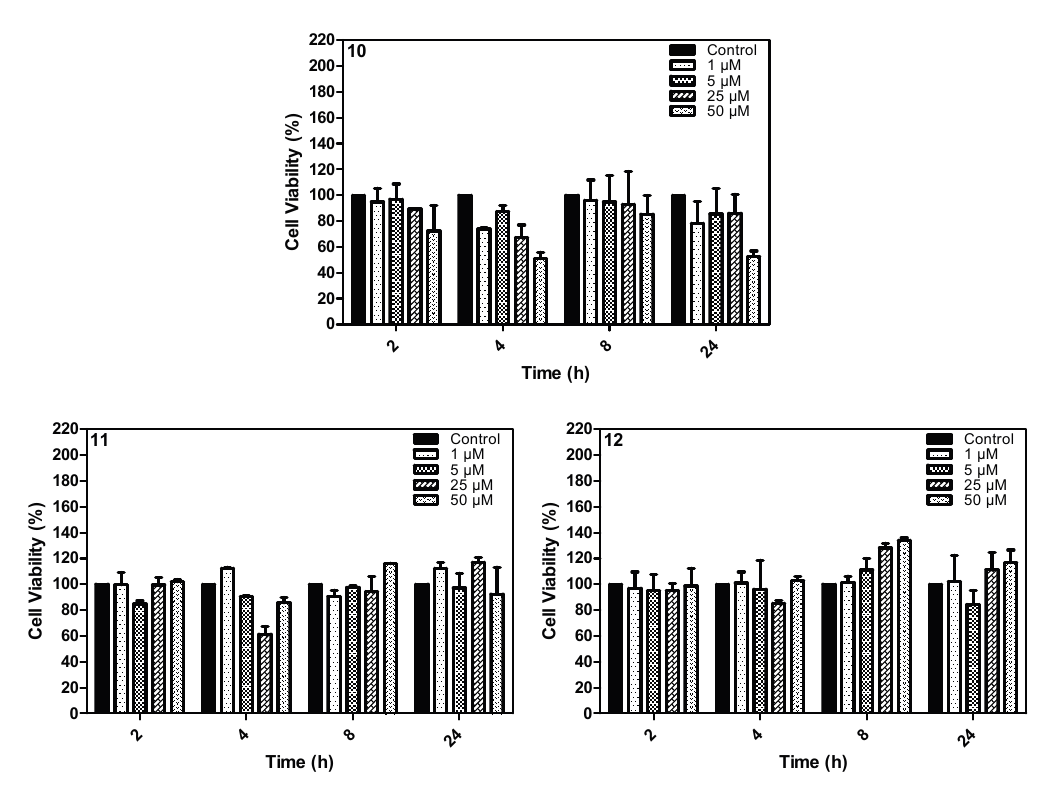
Figure 10. Toxic effect of compounds 10 , 11 and 12 on the MCF-7 cell line after different incubation times and concentrations (50 μ M, 25 μ M, 5 μ M and 1 μ M). The control group did not receive the